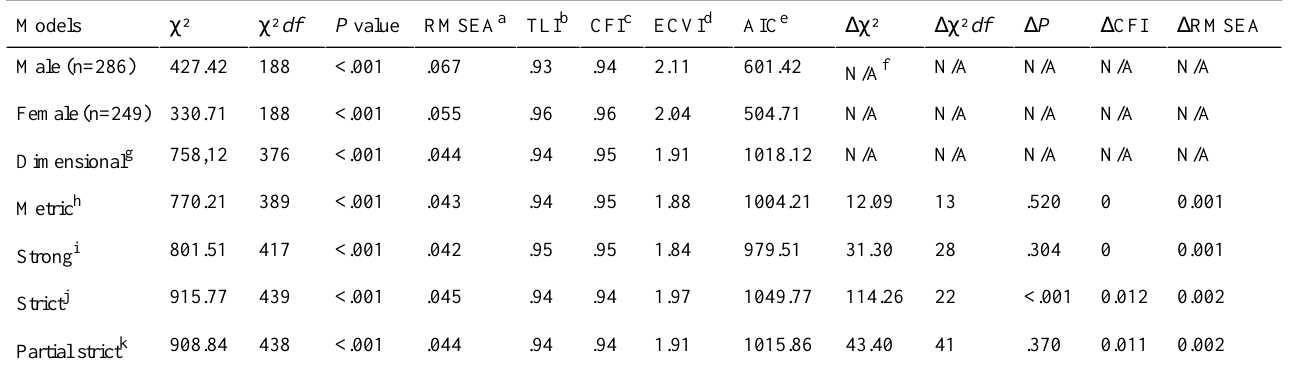
Table 3. Fit indexes of structural modeling to assess sex invariance (n=535).